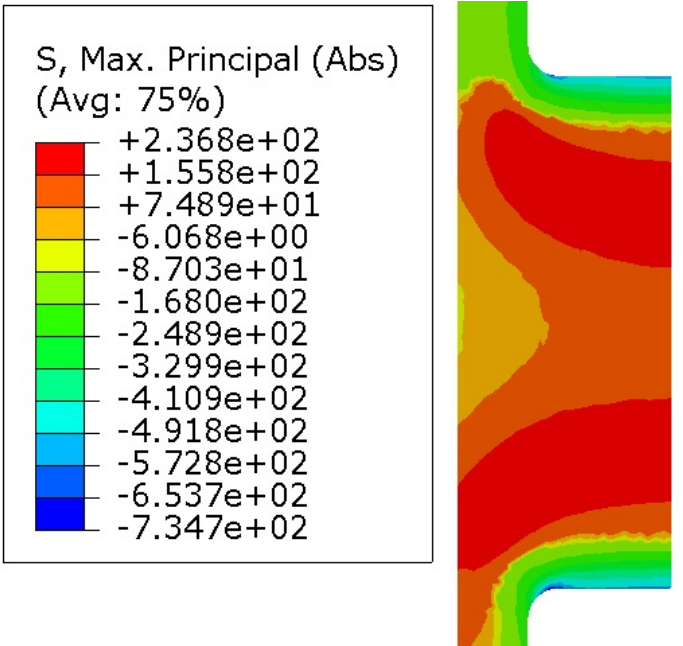
Figure 17. The residual stress field distribution of crankshaft N1.